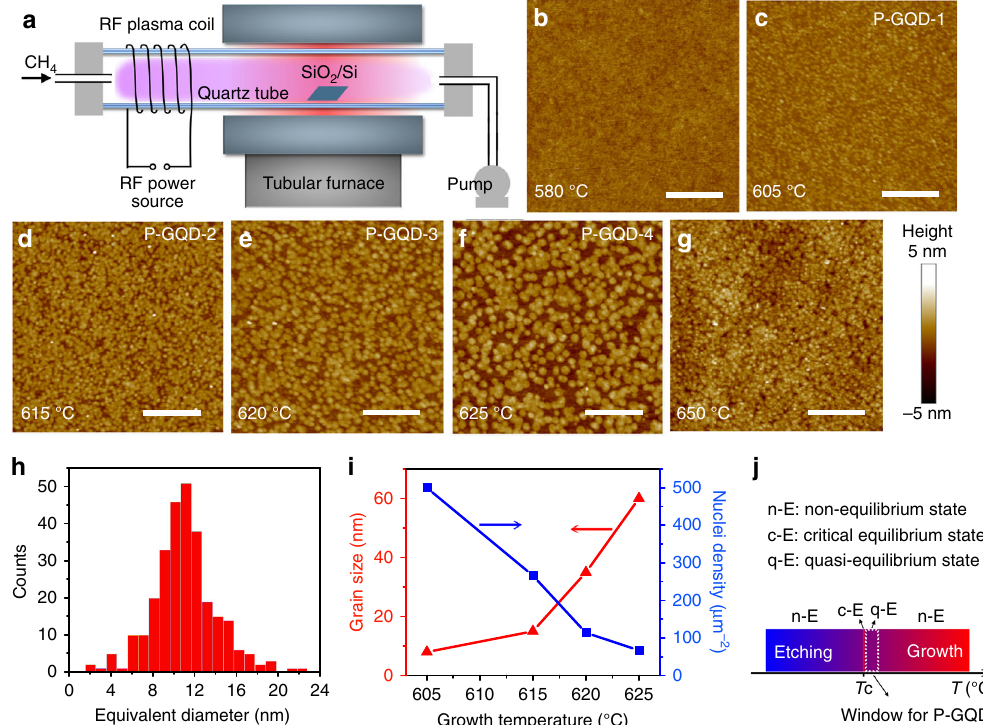
Fig. 1 Growth of P-GQDs by qe-PECVD. a Schematic illustrations of the plasma-enhanced chemical vapor deposition (PECVD) system. b – g Atomic force microscope (AFM) images of samples grown at 580 °C, 605 °C, 615 °C, 620 °C, 625 °C and 650 °C, respectively. h The diameter distribution of the P- GQD-2 sample. i Relationship between grain size, nuclei density and temperature. j Quasi-equilibrium, critical equilibrium and non-equilibrium states at different temperatures. The scale bars in b – g are 500